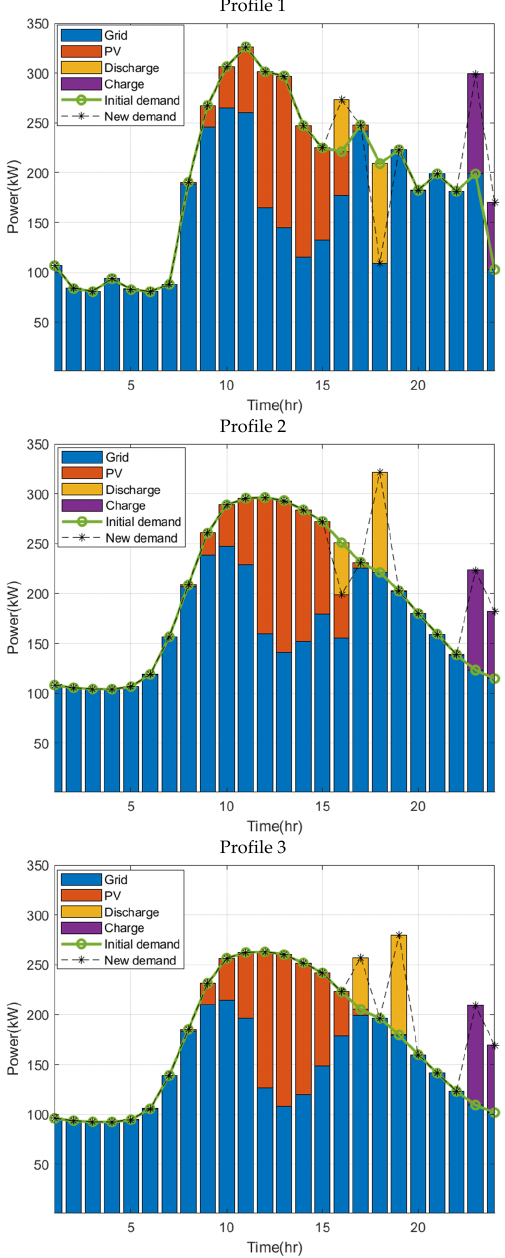
Figure 10. Operation of ESS in January. Profile 1—Using real smart meter data (Section 4.1.1); Profile 2—Using energy bills, standard profiles, and measurement for validation (Section 4.1.2); Profile 3—Using short-term measurement, standard profile, and contracted power (Section 4.1.3).